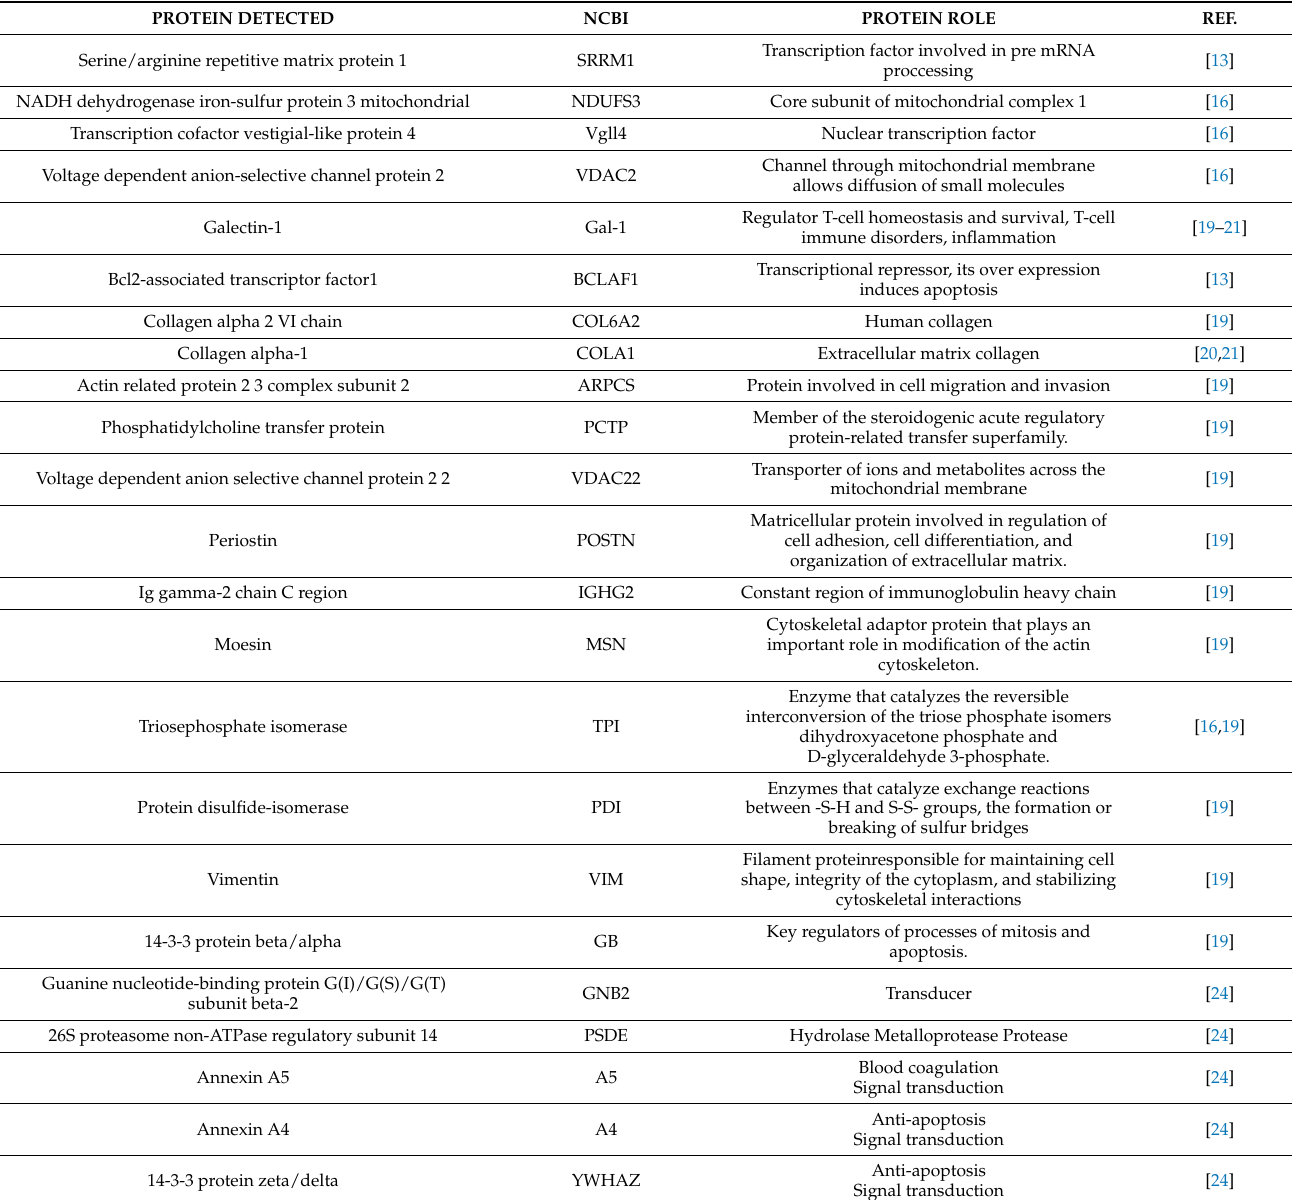
Table 1. List of proteins upregulated in placenta samples of women affected by GDM and their possible role. PROTEIN